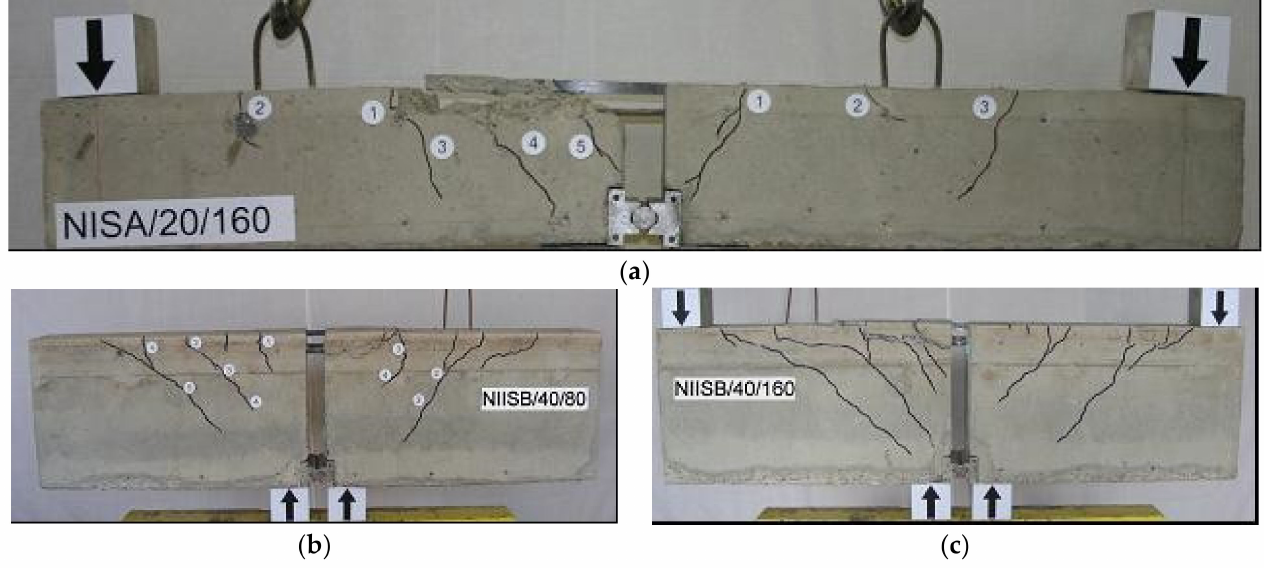
Figure 5. Crack patterns of the selected specimens: ( a ) beam NISA/20/160, ( b ) beam NIISB/40/80, ( c ) beam NIISB/40/160